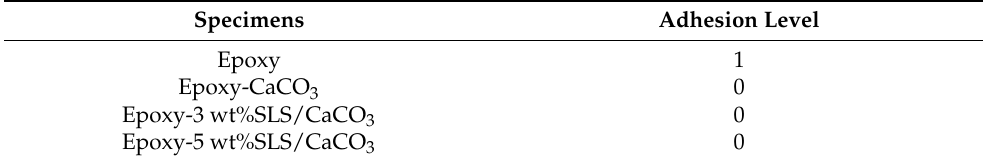
Figure 15. Contact angle images of ( a ) epoxy coating, ( b ) epoxy-CaCO 3 coating, ( c ) epoxy-3 wt%SLS/CaCO 3 coating, and ( d ) epoxy-5 wt%SLS/CaCO 3 coating. Table 4. Adhesion level of different coatings.